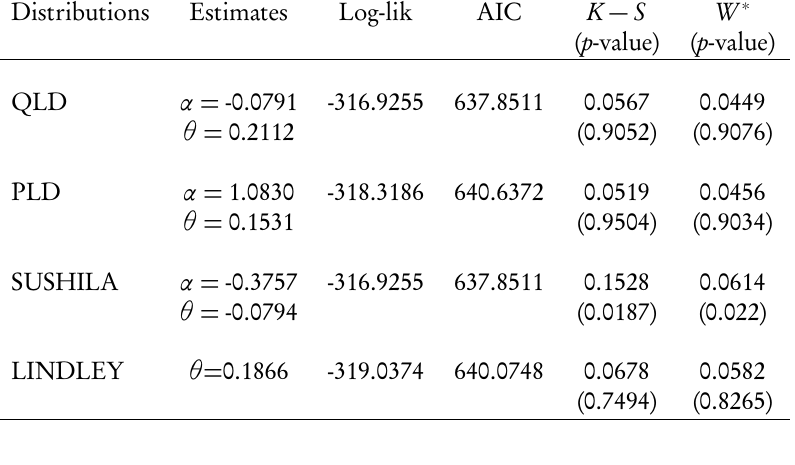
Summary statistic of the results of waiting time data.